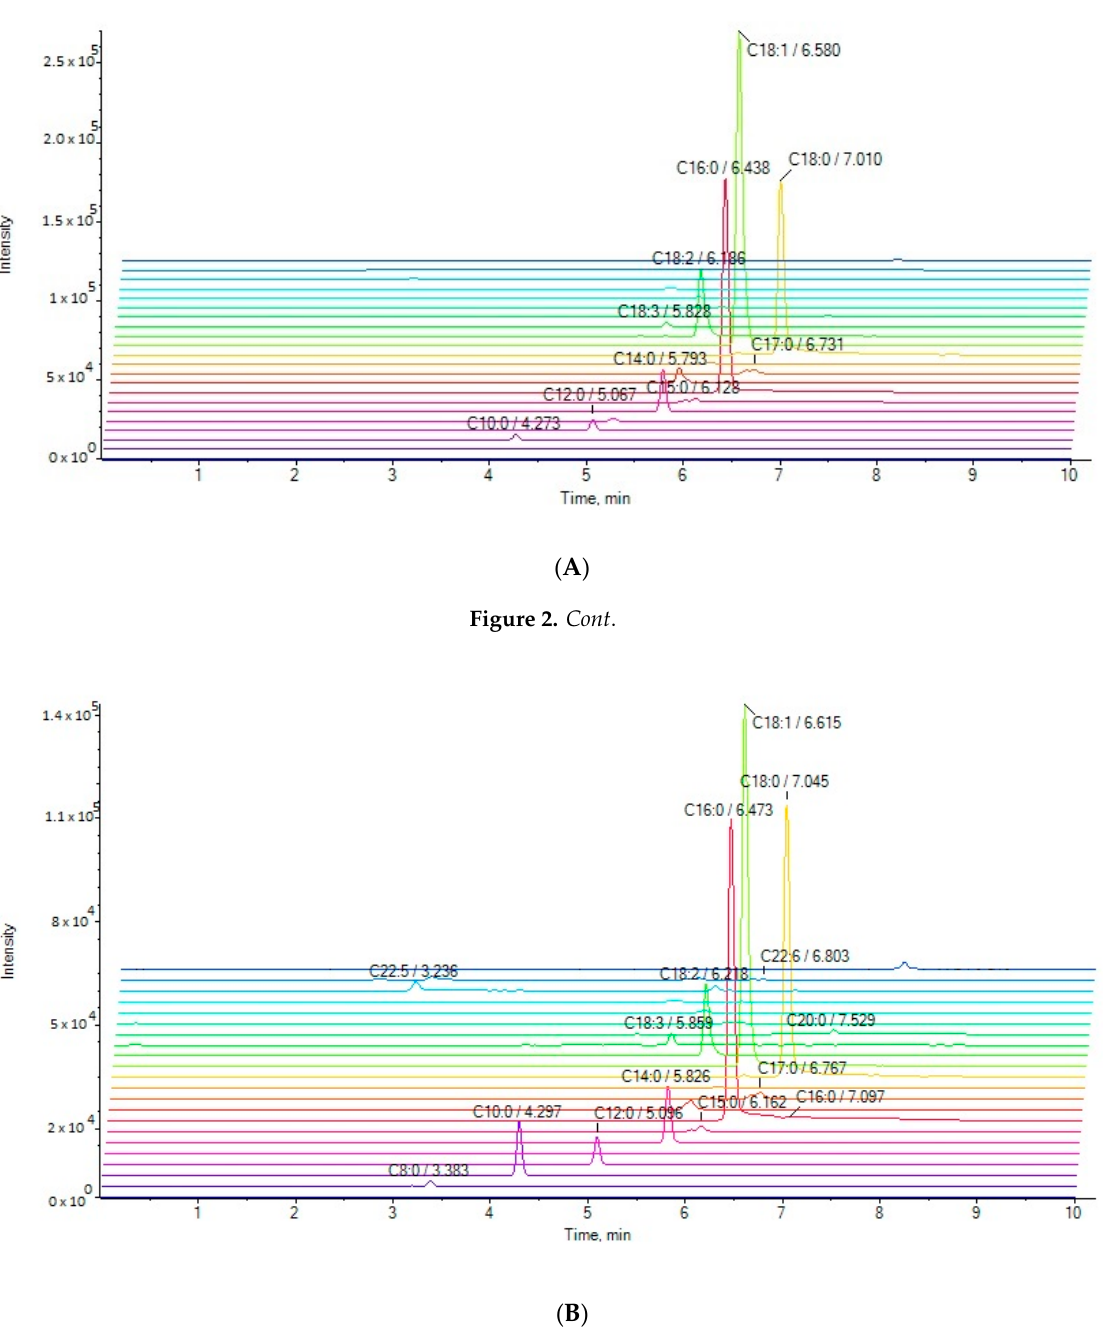
Figure 2. Cont . Molecules 2020 , 25 , x